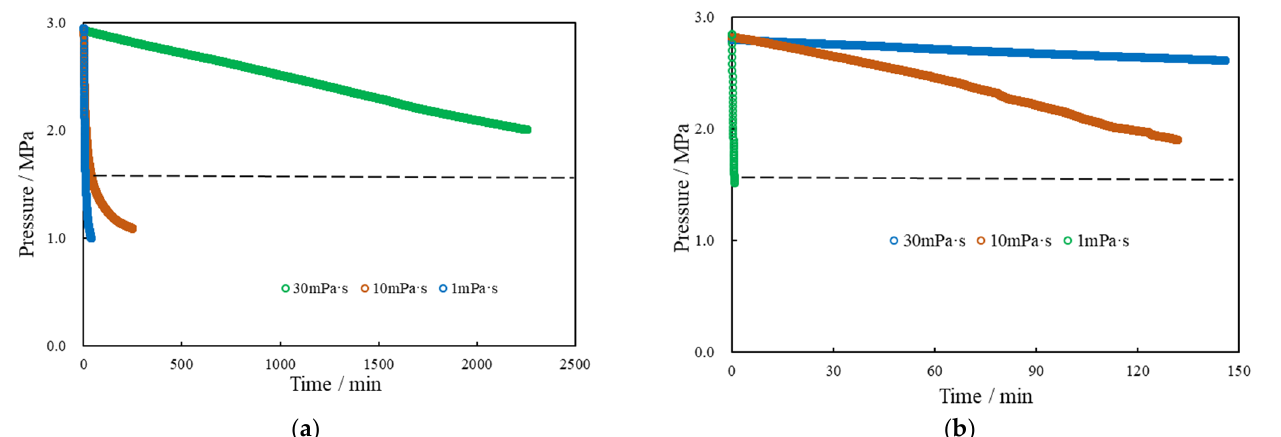
Figure 11. The influence of liquid properties on fracture connectivity. ( a ) Sample Y-1; ( b ) sample C-1.